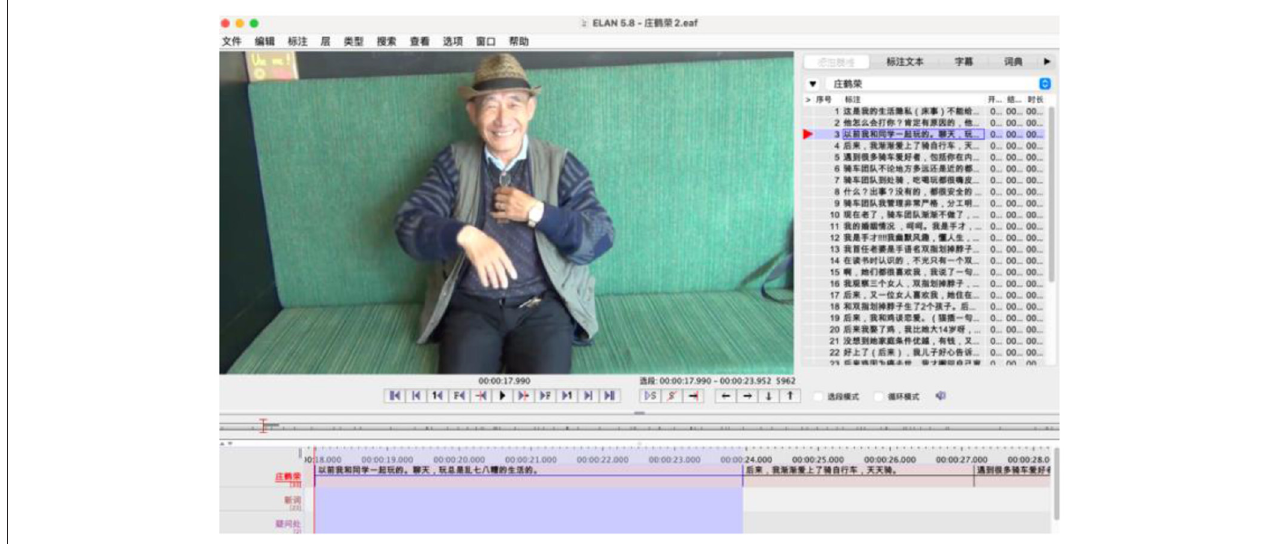
FIGURE 1 | Snapshot of annotated